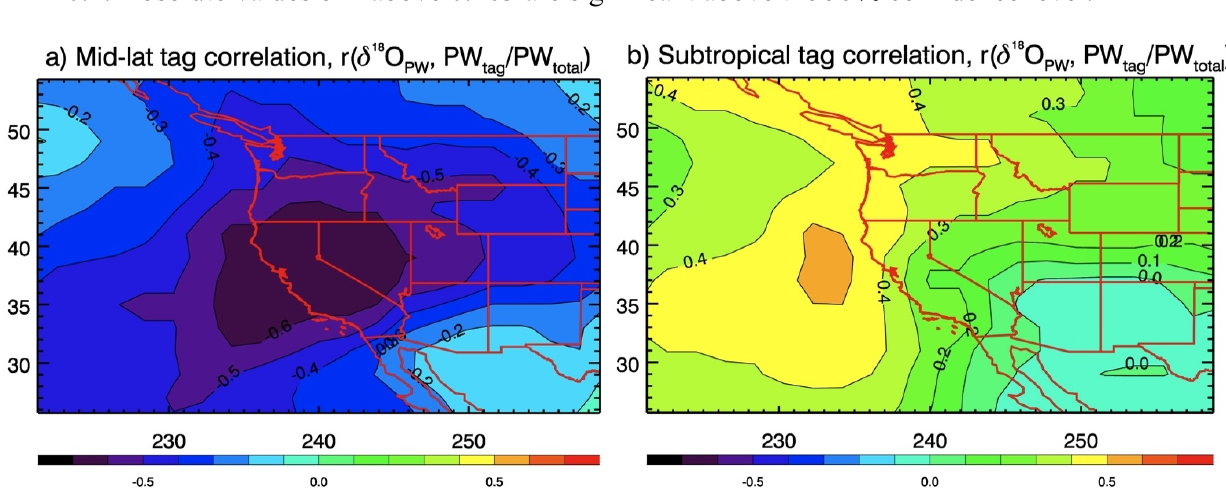
variations and the fraction of PW